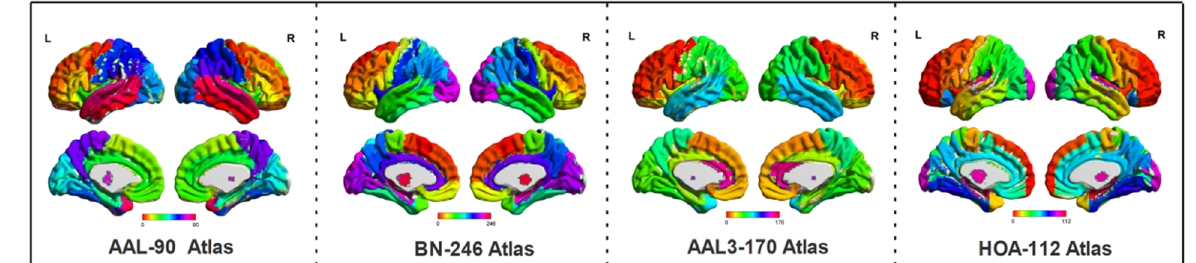
Figure 1. The four atlases, including AAL-90, BN-246, AAL3-170 and HOA-112.